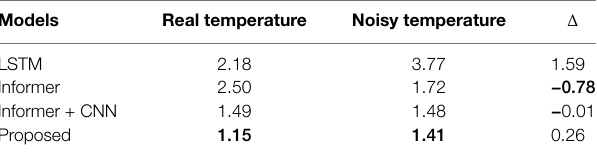
The bold values are the best results as compared to the others.